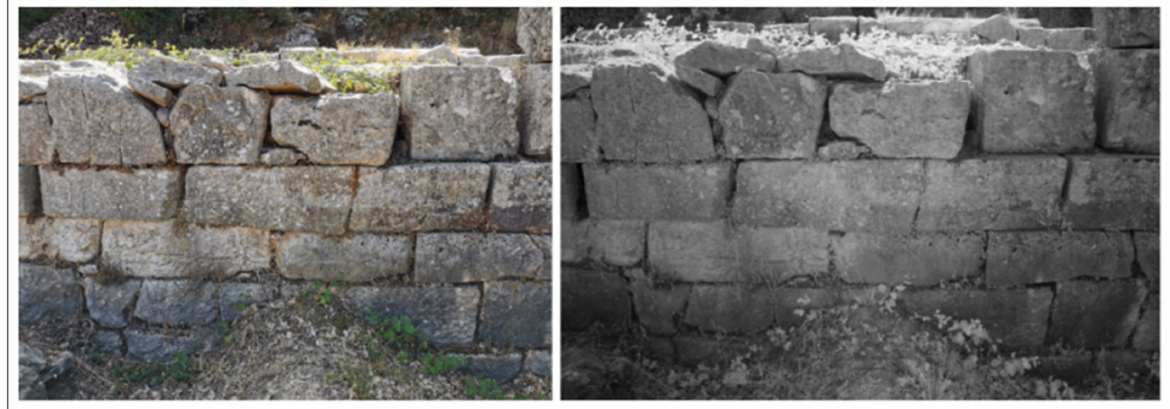
Figure 9. Color and near-infrared images captured at the Temple of Athena and Zeus